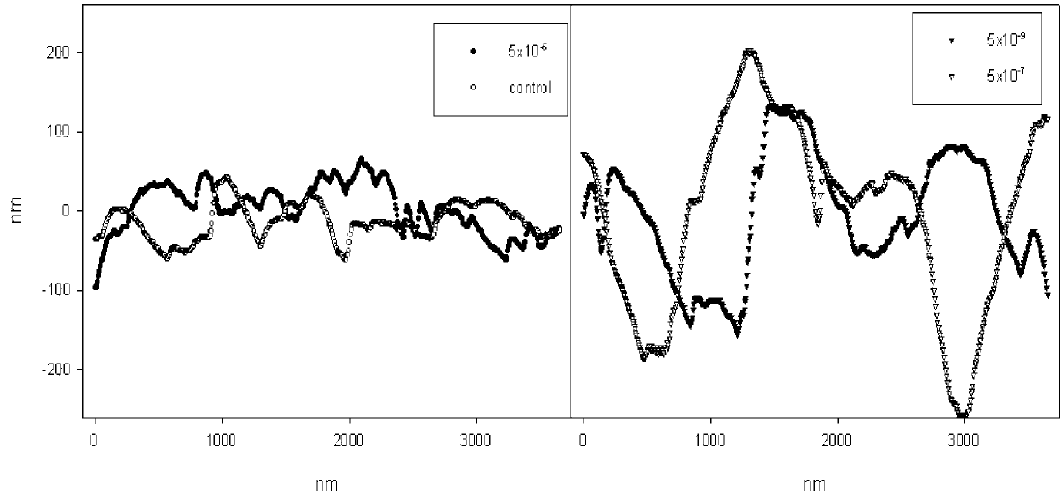
Fig. 6. Line scans along the diagonal of the normalised topographic images. In comparison to the untreated control the height modulation increased with the E 2 concentration from 5 × 10 − 9 M to 5 × 10 − 7 M. With a further increase to 5 × 10 − 5 M the cytotoxic effect becomes visible with flattening of the membrane